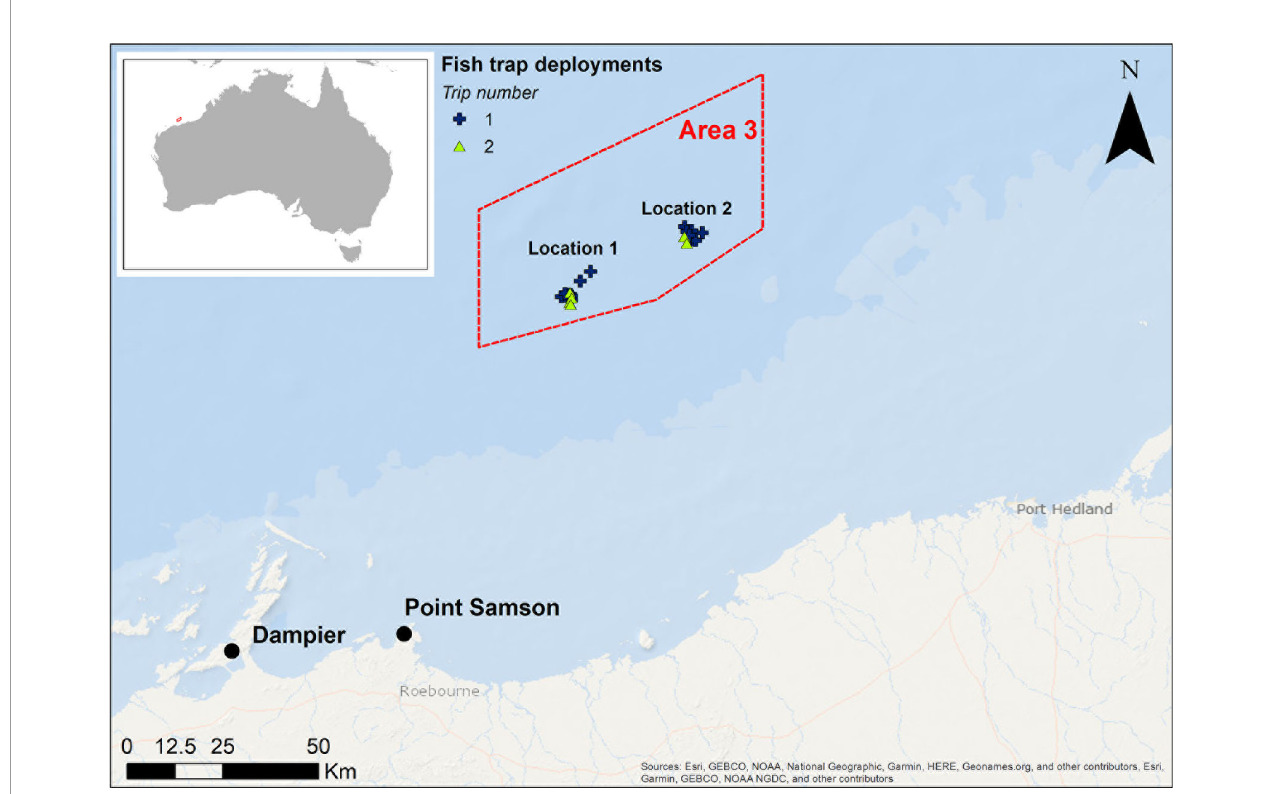
FIGURE 1 | Map of study area showing sampling locations in the Area 3 Management Zone (red box) of the Pilbara Fish Trawl Fishery, which has been a Targeted Fishery Closure since 1998. Sampling was undertaken across two trips in May/June and August/September 2018. This map was created using ArcGIS® software by